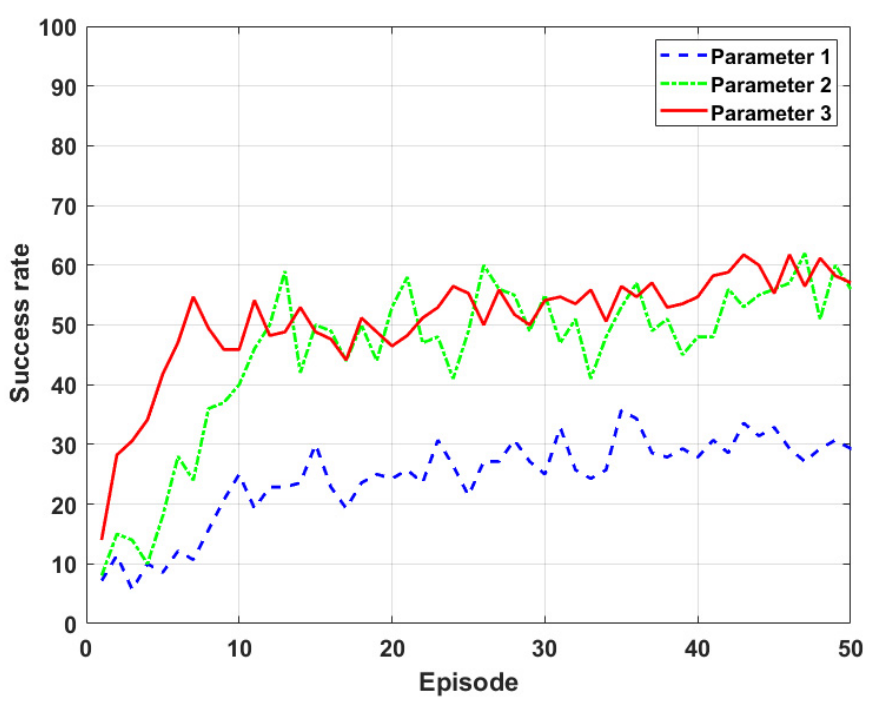
Figure 6. Comparison of parameter performance curves.